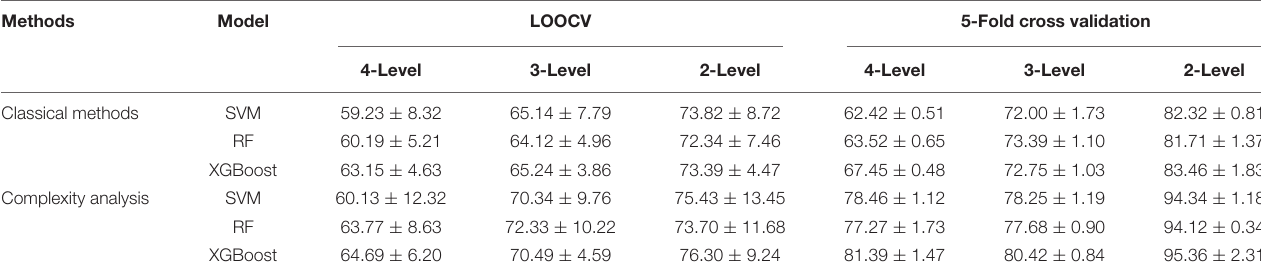
TABLE 2 | The performance between XGBoost and other machine learning methods in the LOOCV and 5-fold